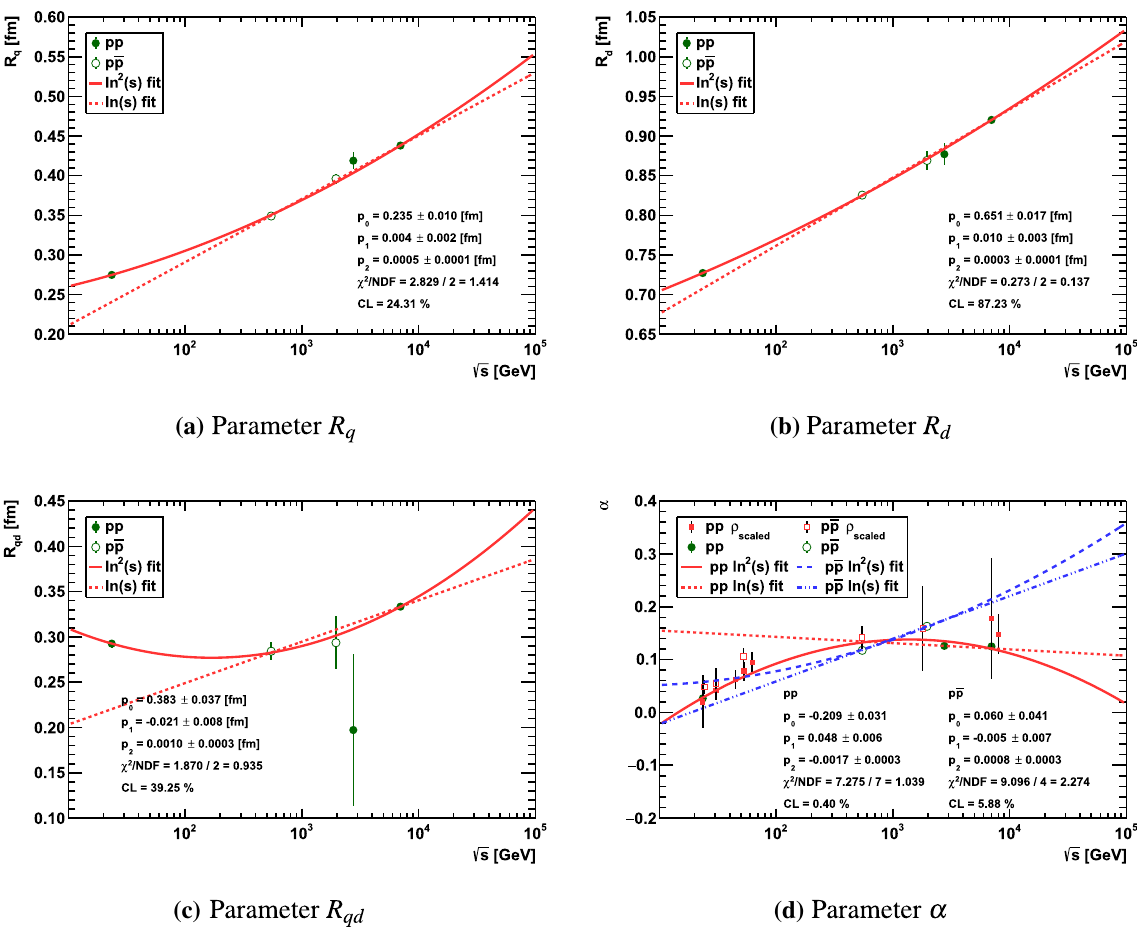
√ s ≤ 8000 GeV with the linear logarithmic model deter- of 546 ≤ mined by the parameters collected in Table 2. It is clear that allowing for quadratic corrections does not change significantly the linear trends √ √ s ≤ 8000 GeV. As a com- s ≤ 8 in the kinematic range of 0 . 5 ≤